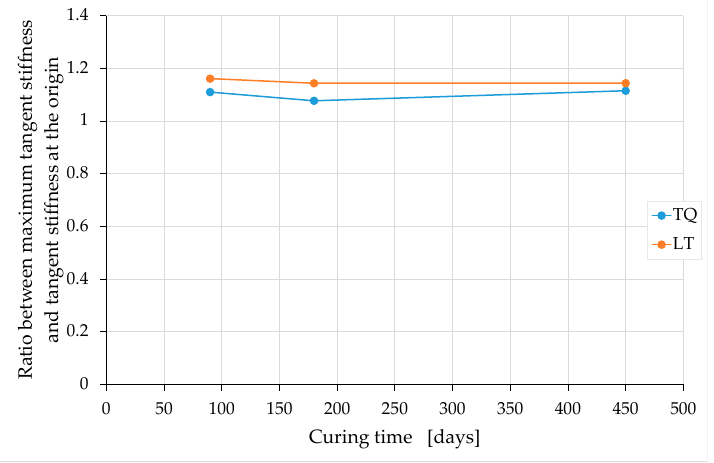
Figure 18. Trend over time of the average values of the ratios between maximum tangent stiffness and tangent stiffness at the origin: TQ and LT mixes.